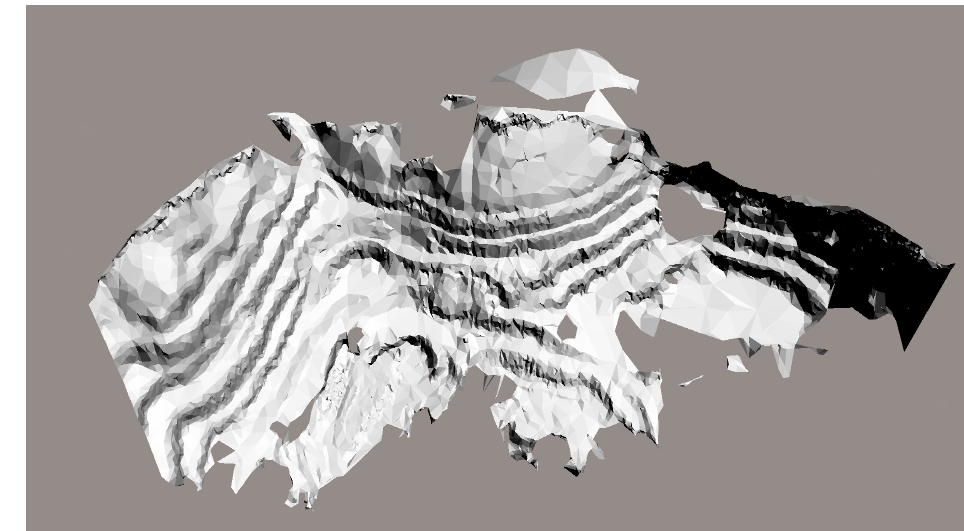
Figure 12. 3D model of the study field.